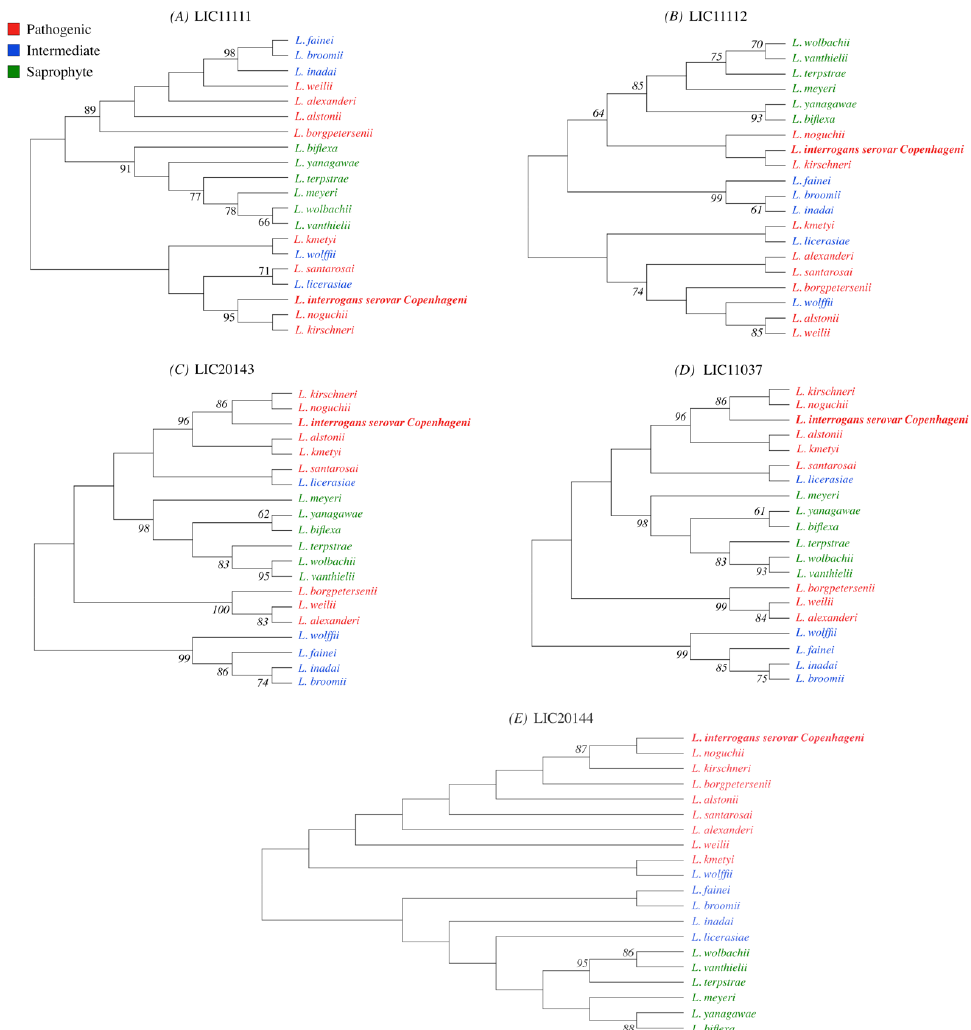
Figure 1. Evolutionary analysis by maximum likelihood method among Leptospira strains for ( A ) LIC11111, ( B ) LIC11112, ( C ) LIC20143, ( D ) LIC11037, and ( E ) LIC20144. Amino acids sequences from